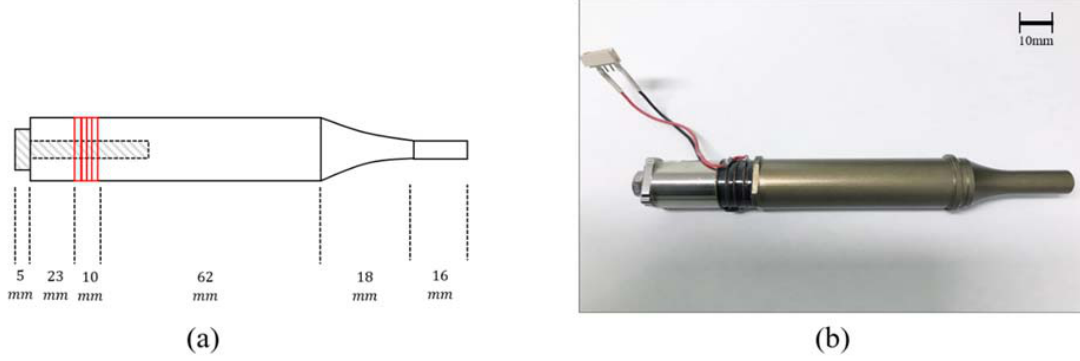
Figure 2. Transducer configuration used in this study: ( a ) simplified diagram; ( b ) actual transducer. Table 1. Material properties by transducer parts.